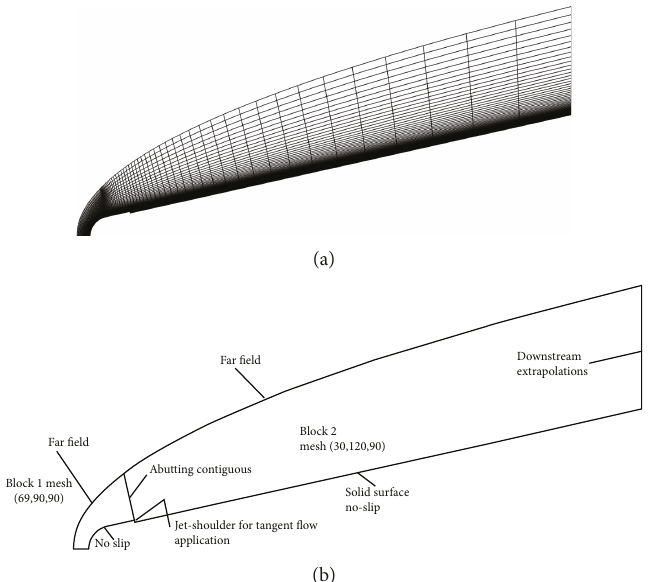
Figure 6: Tangent-slot model (a) mesh block 1 (69,90,90), mesh block 2 (30,120,90). (b) Topology showing boundary conditions.